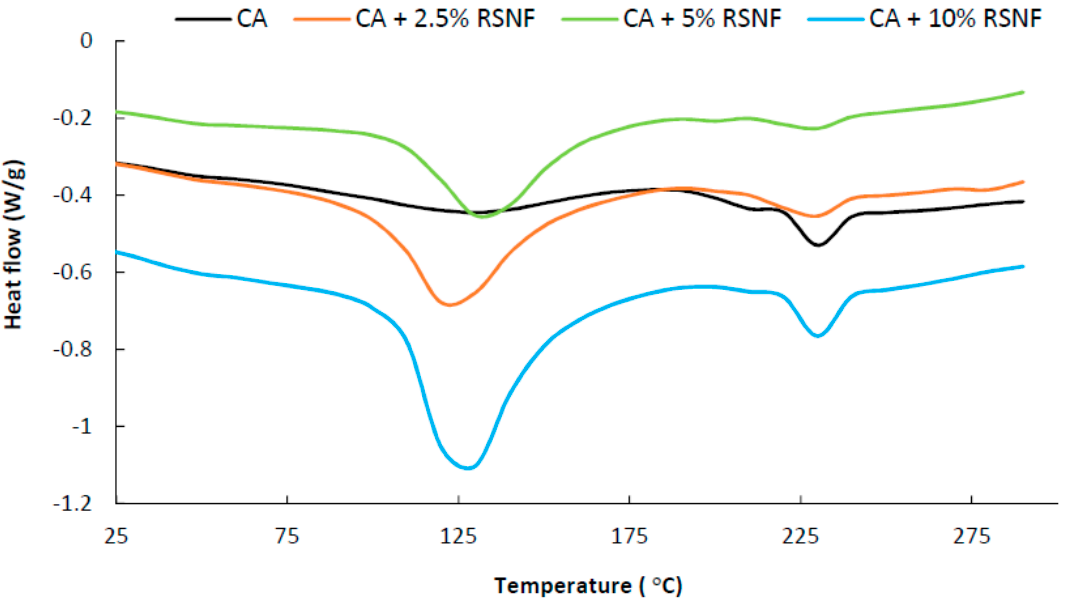
Figure 11. DSC curves of CA and CA/RSNF films.